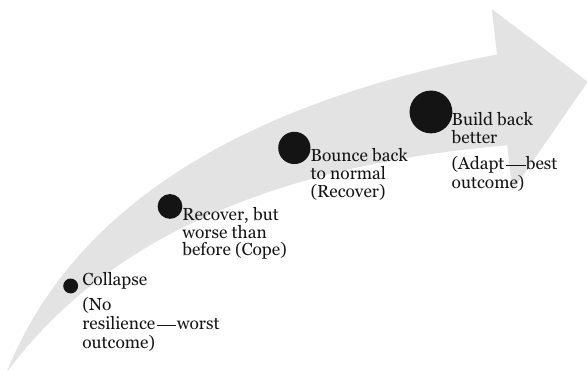
Fig. 1 The nature of resilience reaction as adapted from literature. Source : Fischbacher-Smith and Fischbacher-Smith (2009), Magis (2010), United Nations International Strategy for Disaster Reduction (UNISDR 2015), and Department for International Development (DFID 2011) resilience approach